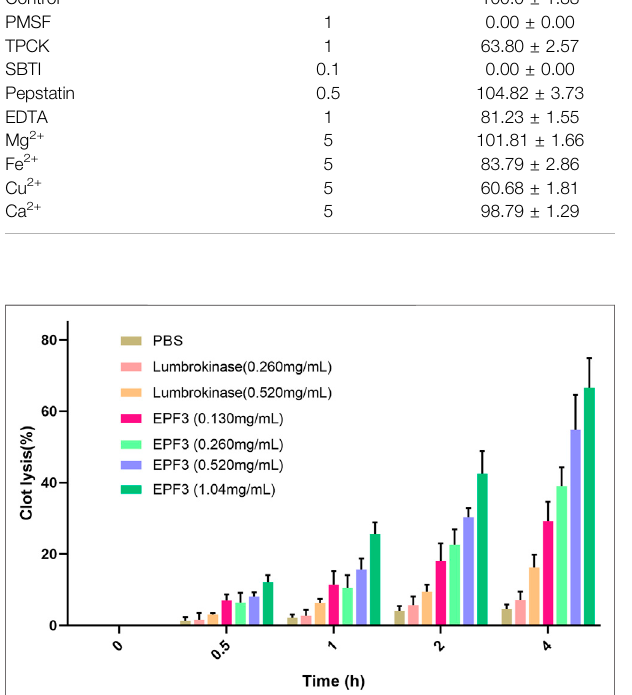
FIGURE5| ThelysisofbloodclotbyEPF3comparedwithlumbrokinase( n (cid:1) 3).